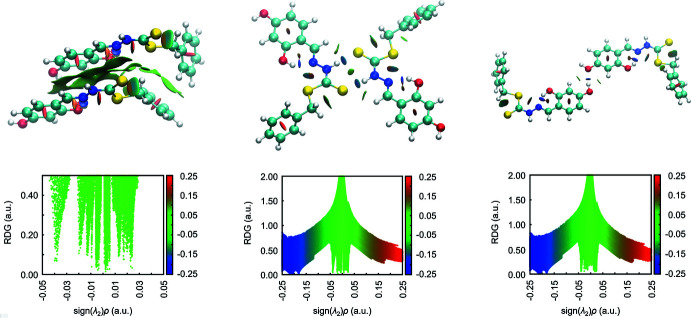
The non-covalent inter­action plot and corresponding RDG versus sign(λ2)ρ(r) plots for the dimeric aggregates sustained by (a) a combination of π(C3–C8)–quasi-π(N4,C17–C19,O3,H3O), quasi-π(N2,C2–C4,O1,H1O)–quasi-π(S4,C16,N3,N4), C24—H24A⋯S2, C14–H14⋯π(C25–C30) and C15—H15⋯\p(C25–C30) inter­actions between S1- and S3-mol­ecules, (b) N1—H1N⋯S3 and N3—H3N⋯S1 hydrogen bonds and (c) O2—H2O⋯O4 inter­actions.